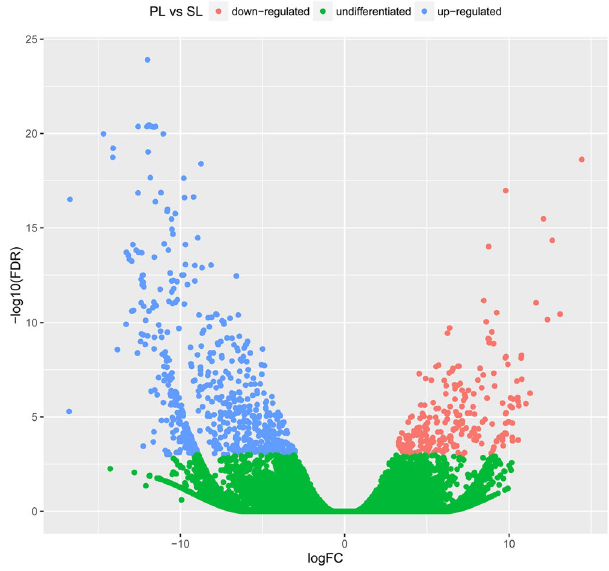
Figure 3. Differential expression analysis of unigenes in the primary laticifers (PL) versus the secondary laticifers (SL). The LogFC (log2 Fold Change) is used as the x-axis and –log10FDR (False Discovery Rate) is used as the y-axis. The total number of unigenes is 70,933. Of those 70,089 were not DEGs (cut-off FDR ≤ 0.001, highlighted in green), 597 unigenes were up-regulated in PL (highlighted in blue), and 247 unigenes were down-regulated (highlighted in